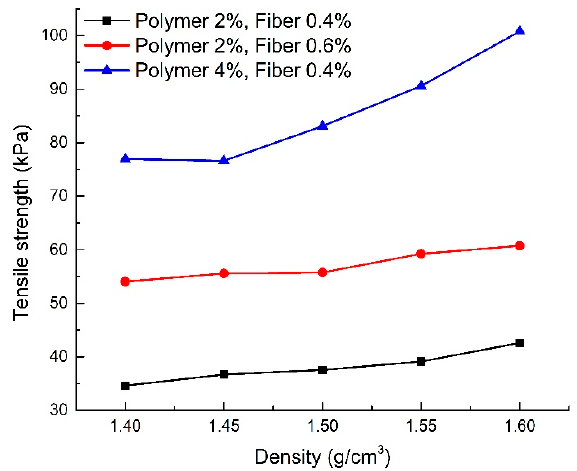
Figure 14. Tensile strength of reinforced sand with different dry density.